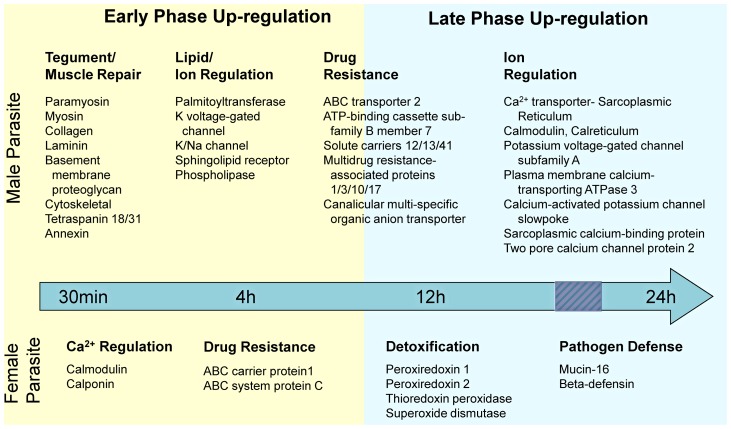
Overview of genes transcriptionally up-regulated in Schistosoma japonicum in response to in vivo exposure to praziquantel.Broad functions known to be important to schistosome biology, and specific example genes are presented. Responses were noted separately for male and female parasites, and were classified as either “Early Phase” representing time points 30 min and 4 h, or “Late Phase” representative of 12 h and 24 h, after administration of praziquantel. Up-regulation of genes was considered relative to pre-drug administration.